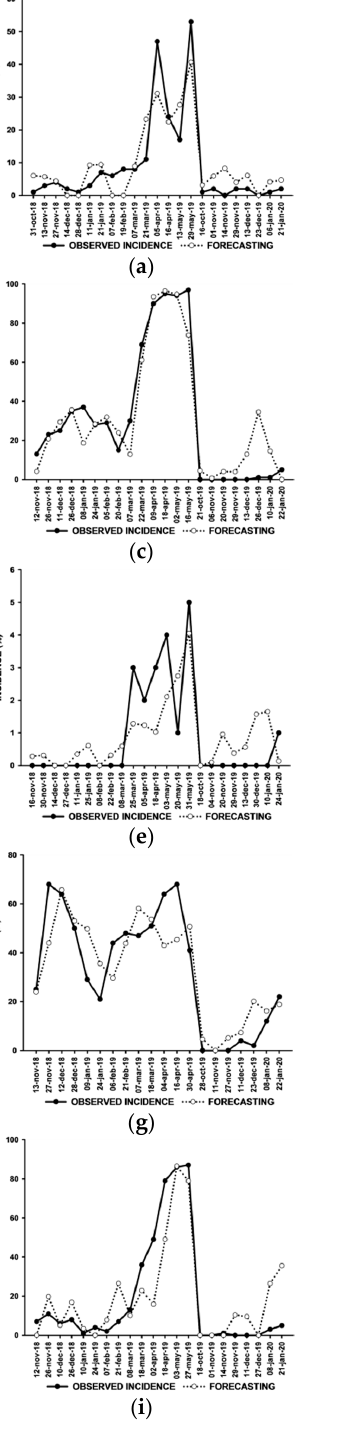
Figure 5. Performance of adjusted models excluding harvest for coffee rust forecast estimates com- pared to field observed data: ( a ) Carmo do Rio Claro, model 15–45 DBRI (Days before rust incidence) with all variables; ( b ) Carmo do Rio Claro, model 2 15–45 DBRI excluding variables; ( c ) Monte Santo de Minas, model 15–45 DBRI with all variables; ( d ) Monte Santo de Minas, model 2 15–45 DBRI ex- cluding variables; ( e ) Nova Resende, model 2 15–45 DBRI with variable exclusion; ( f ) Rio Parana í ba, model 15–45 DBRI with all variables; ( g ) Rio Parana í ba, model 15–45 DBRI excluding variables; ( h ) Serra do Salitre, model 15–45 DBRI with all variables; ( i ) Serra do Salitre, model 2 15–45 DBRI excluding